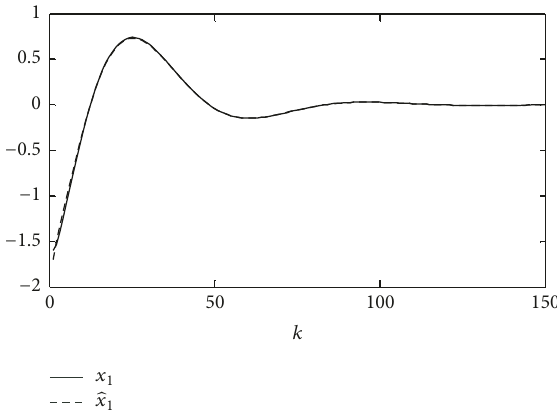
Figure 5: State 𝑥 1 and its estimated value ̂𝑥 1